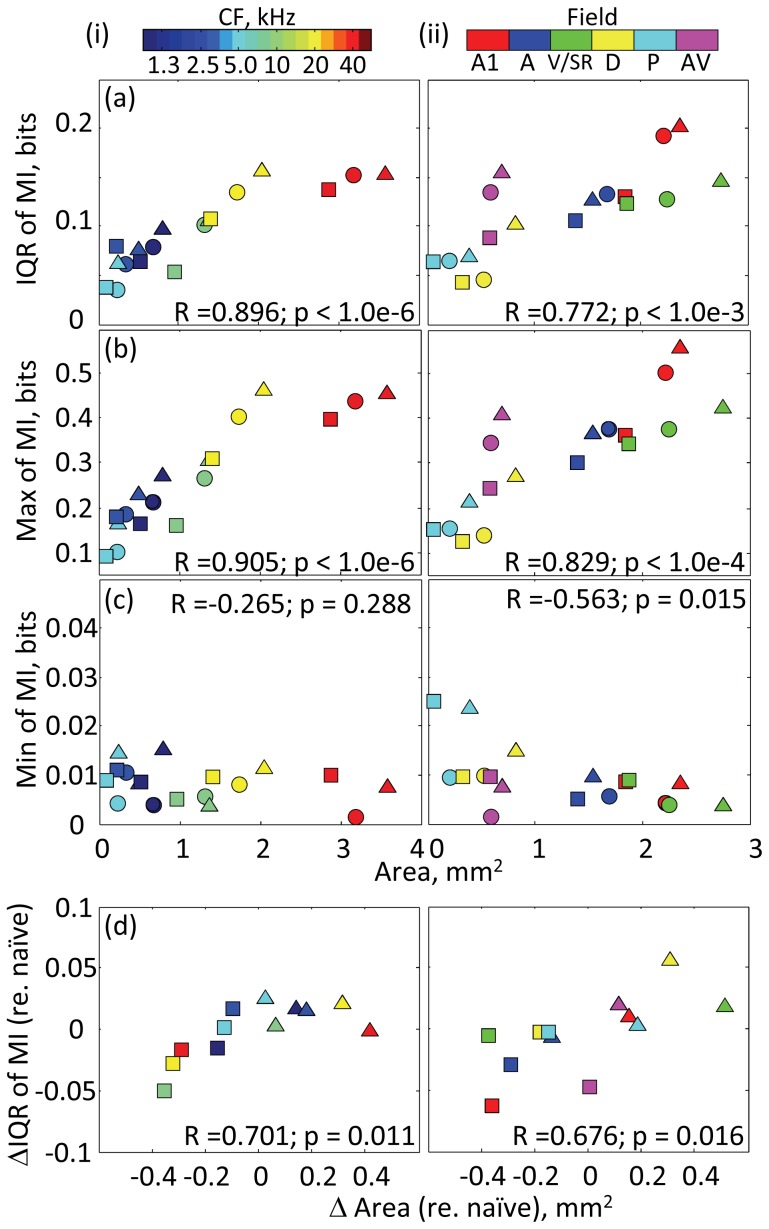
MI distribution on the functional map.(a) Interquartile range (IQR) of MI with respect to representational area with a given property: (i) CF; and (ii) Auditory field. The shapes of symbols indicate the test groups: circle, naïve; triangle, day 4; and square, day 20. R and p are Pearson’s correlation and its significance level (t-test). (b) Maximum value of MI. (c) Minimum value of MI. (d) Learning induced changes of MI IQR (ΔIQR) and representational area (Δarea).